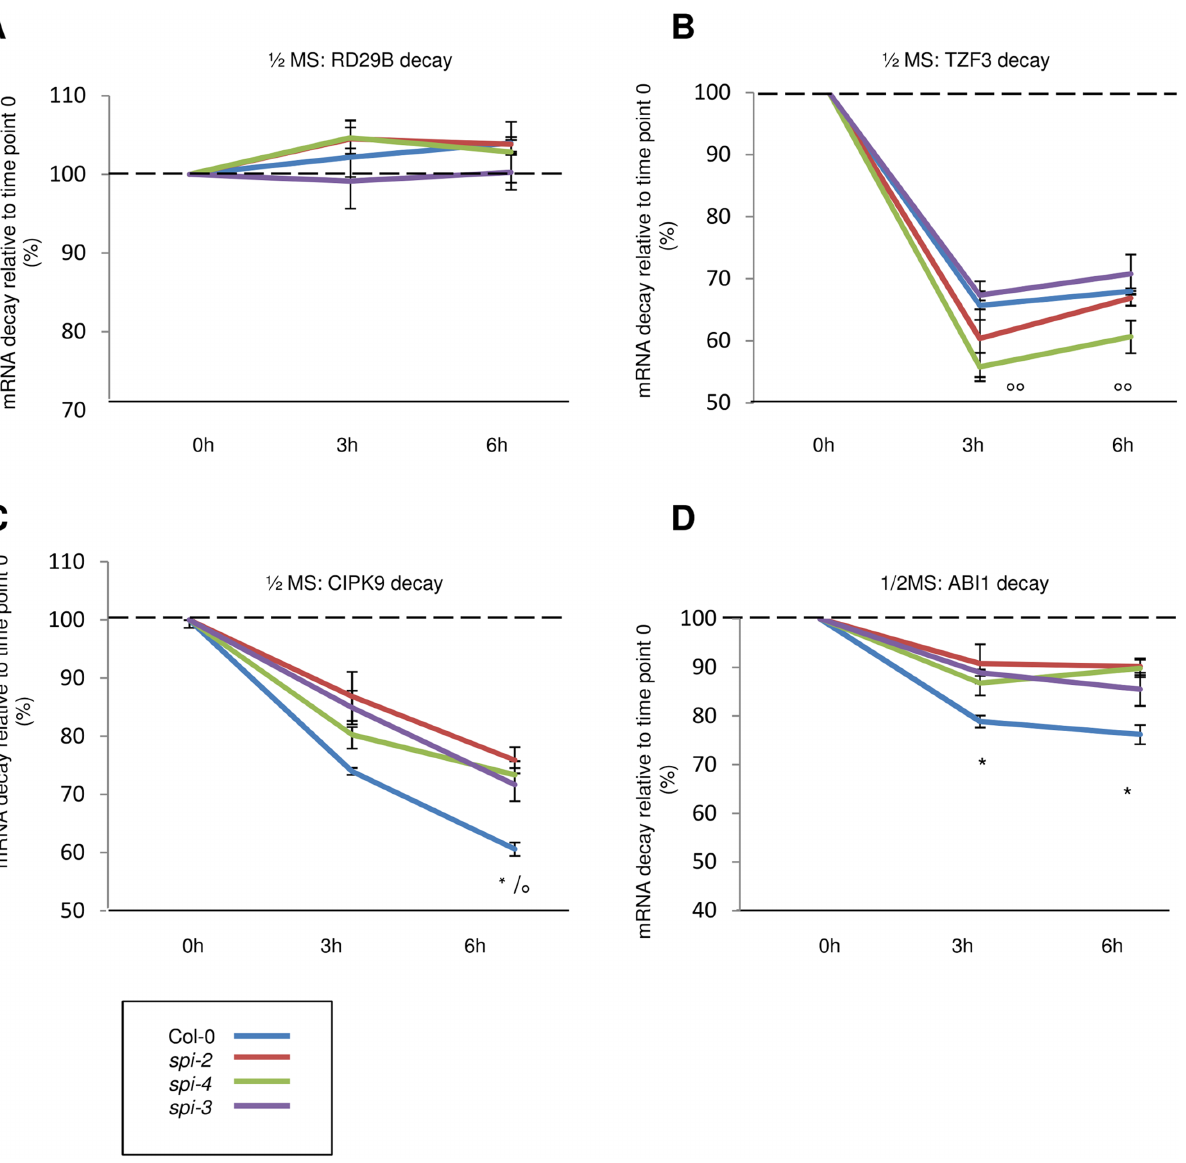
Fig 7. mRNA decay is not accelerated in spi mutants under nonstress conditions. mRNA stabilities (in %) were determined 3 h and 6 h after application of Actinomycin D (ActD), relative to time point 0 under nonstress conditions for RD29B (A), TZF3 (B), CIPK9 (C), and ABI1 (D). Data denote the average from three independent biological and two technical replicates. Error bars represent the standard error of the mean. Two-tailed student ’ s t tests were performed to compare 18S rRNA normalized expression levels either of spi alleles with that of wild-type ( * p < 0.05; ** p < 0.01 of all spi alleles), or of ActD-treated samples with that of untreated samples (time point 0) (° p < 0.05; °° p < 0.01 of all treated